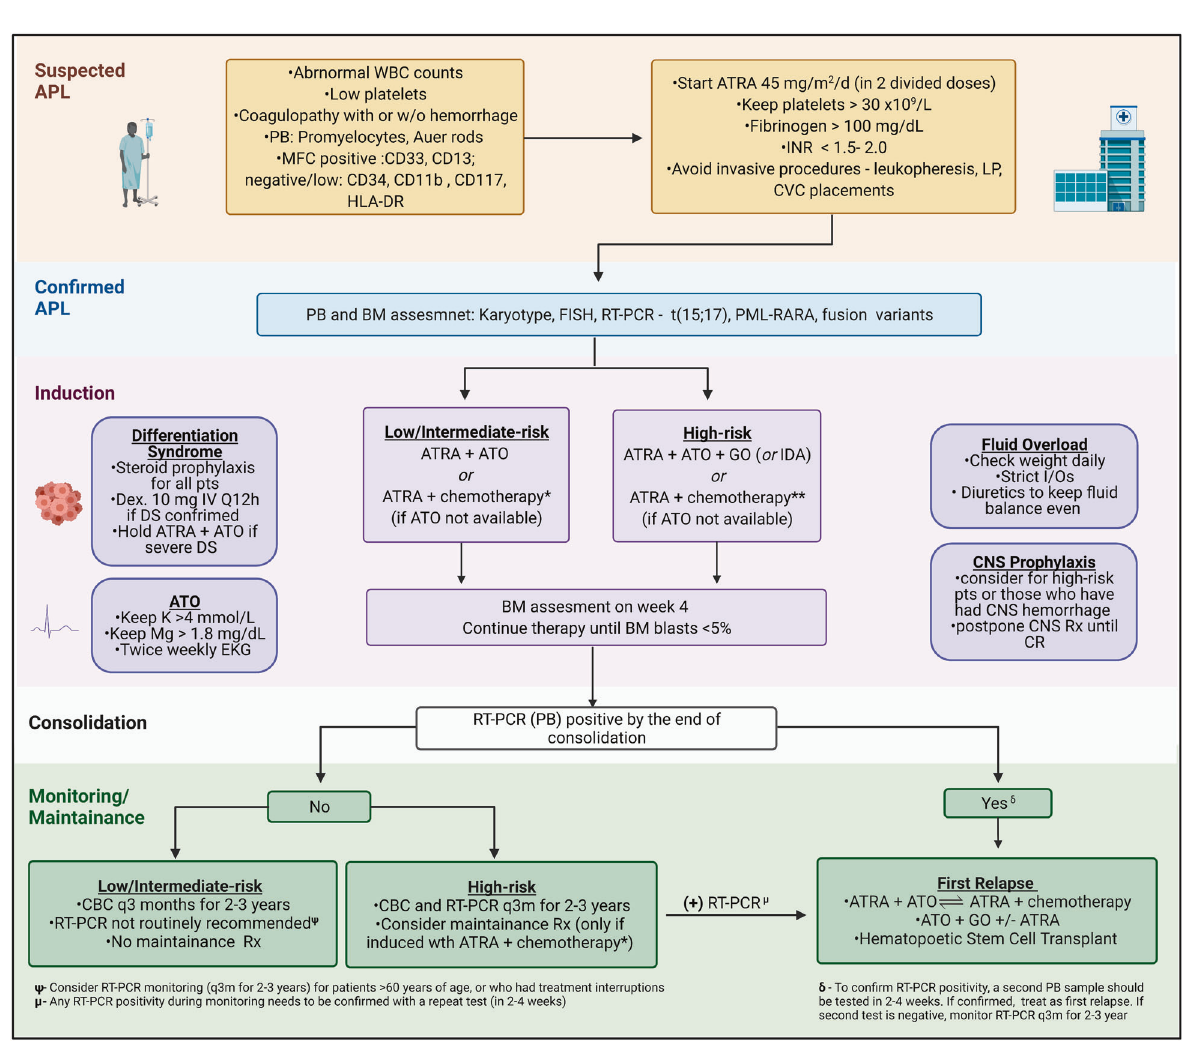
Fig. 2 Approach to suspected APL and treatment algorithm. APL acute promyelocytic leukemia, WBC white blood cell count, PB peripheral blood, BM bone marrow, MFC multicolor fl ow cytometry, ATRA retinoic acid, LP lumbar puncture, CVC central venous catheter, DS differentiation syndrome, Dex dexamethasone, ATO arsenic trioxide, GO gemtuzumab ozogamicin, IDA idarubicin, I/Os intake and output, CNS central nervous system, RT-PCR reverse transcription polymerase chain reaction. *Lower risk APL: ATRA + IDA or ATRA + GO **Higher risk: ATRA + IDA or ATRA + DNR + Clinical signs of coagulopathy vary from mild mucocutaneous coagulopathy consisting of elevated partial thromboplastin time bleeding to severe intracranial or pulmonary hemorrhage. On rare (PTT), prothrombin time (PT), and D-dimers, together with occasions, some patients may have concurrent deep-vein hypo fi brinogenemia, and thrombocytopenia is another common thrombosis or pulmonary emboli, or other thrombotic events [18]. feature present in three-quarters of the patients at diagnosis [15].